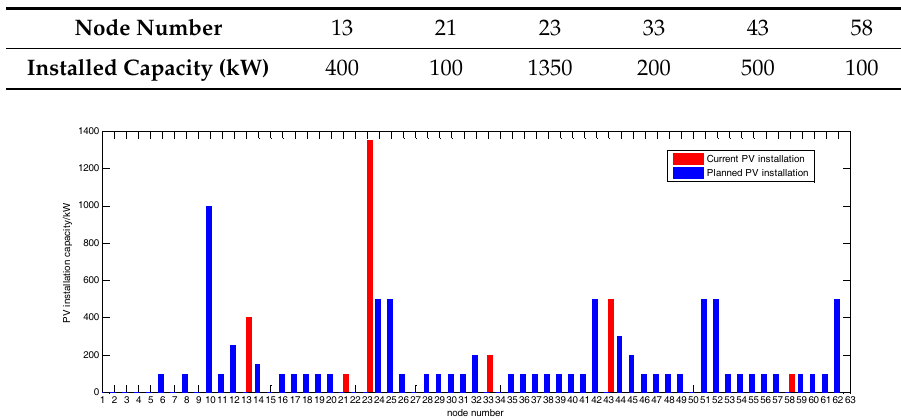
Figure 5. Current and planned PV installations in the distribution network.